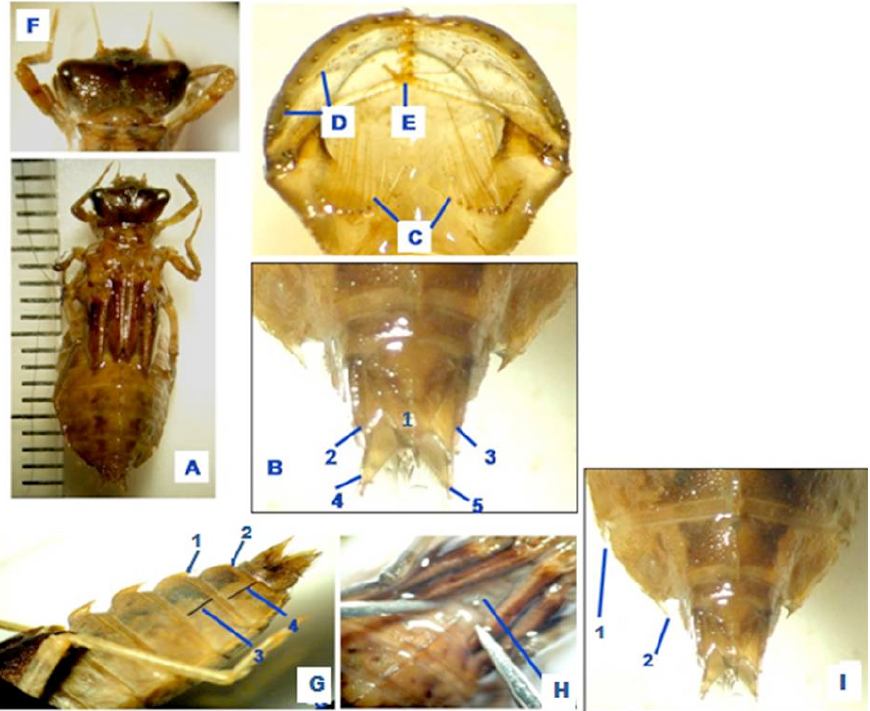
Image 2. Different characters of Leucorrhinia sp. larva of KLNP, Manipur, northeastern India. © Kiranbala Takhelmayum A - L eucorrhinia sp.; B - (1) Epiproct, (2-3) Cerci, (4-5) Paraproct; C - Premental Setae; D - Palpal setae; E - Ligula; F - Head; G - (1-8 th ) mid dorsal spine, (2-9 th ) mid-dorsal spine, (3-8 th ) mid-dorsal segment, (4-9 th ) mid-dorsal segment; H - 3 rd mid-dorsal spine; I - (1-8 th ) lateral spine, (2-9 th ) lateral